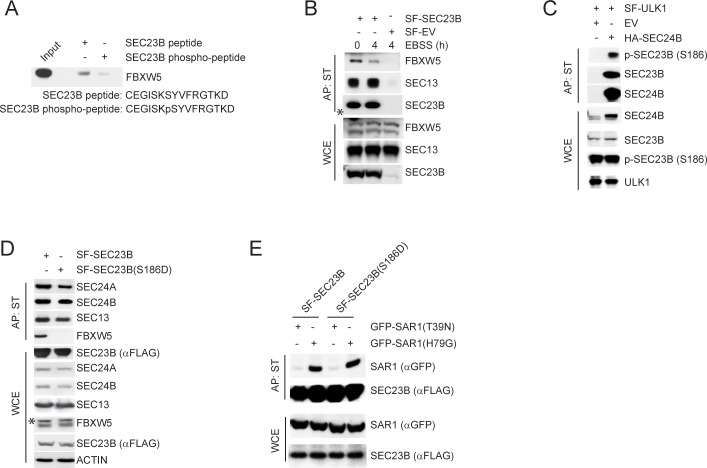
ULK1-mediated phosphorylation of SEC23B on S186 prevents the FBXW5-dependent degradation of SEC23B.(A) A non-phosphorylated SEC23B peptide and an equivalent phospho-peptide (sequences are indicated below the panels) were conjugated to beads and used in an in vitro binding assay with FBXW5 that was in vitro transcribed/translated using a rabbit reticulocyte system. Bound FBXW5 was detected by immunoblotting. (B) HEK293T cells were transfected with either a Streptag-FLAG empty vector (SF-EV) or Streptag-FLAG-tagged SEC23B (SF-SEC23B). Twenty-four hours after transfection, cells were nutrient-starved with EBSS for the indicated times and treated with MLN4924 for 4 hr before harvesting them for affinity-purification (AP) with Streptactin (ST) beads and immunoblotting as indicated. (WCE, whole cell extracts). The white asterisk indicates a non-specific band. (C) HEK239T cells were transfected with an empty vector (EV) or HA-tagged SEC24B together with Streptag-FLAG tagged ULK1 (SF-ULK1) as indicated. Twenty-four hours after transfection, cells were harvested for immunoprecipitation (IP) with HA beads and immunoblotting as indicated. (WCE, whole cell extracts). (D) HEK239T cells were transfected with either Streptag-FLAG tagged wild-type SEC23B or the phospho-mimetic SEC23B(S186D) mutant (also Streptag-FLAG tagged). Twenty-four hours after transfection, cells were harvested for affinity-purification (AP) with Streptactin (ST) beads and immunoblotting as indicated. (WCE, whole cell extracts). (E) HEK239T cells were transfected with either Streptag-FLAG tagged SEC23B (SF-SEC23B) or SF-SEC23B(S186D), in combination with the indicated GFP-tagged SAR1 mutants. Twenty-four hours after transfection, cells were harvested for affinity-purification (AP) with Streptactin (ST) beads and immunoblotting as indicated.